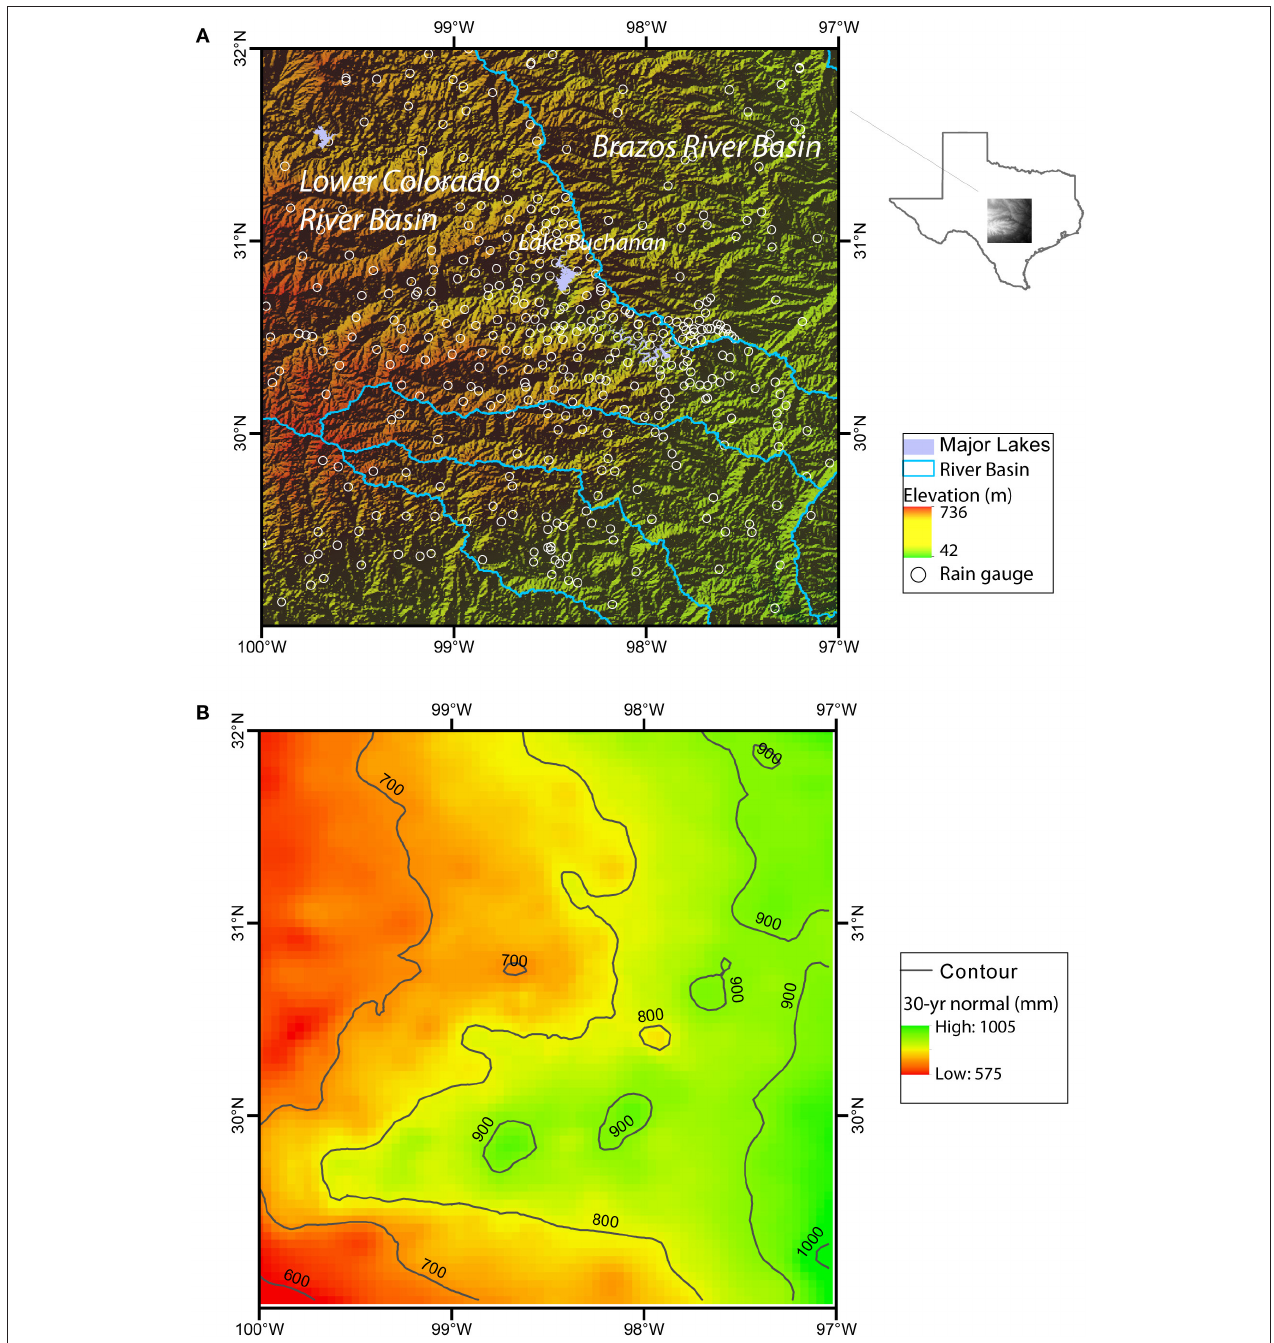
FIGURE 1 | (A) Study area boundary (lat: 29–32 ◦ N, lon: 100–97 ◦ W) and the shaded relief map (open circles correspond to the existing rain gauges as of Jan 2017); (B) 30-years precipitation normal extracted from PRISM, where color and contour lines represent total rain amount in mm.